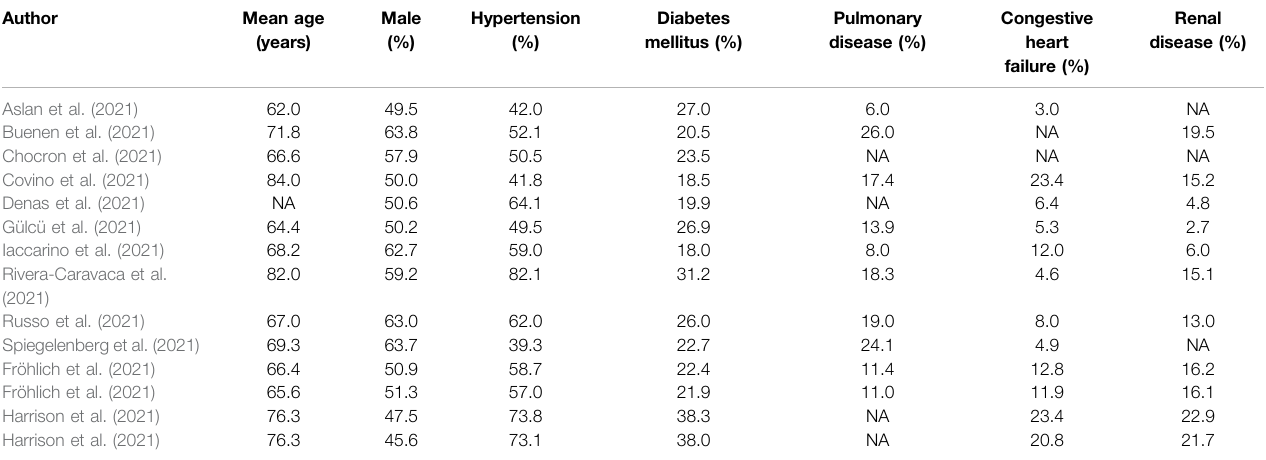
TABLE 2 | Patient demographics and clinical characteristics of included studies.